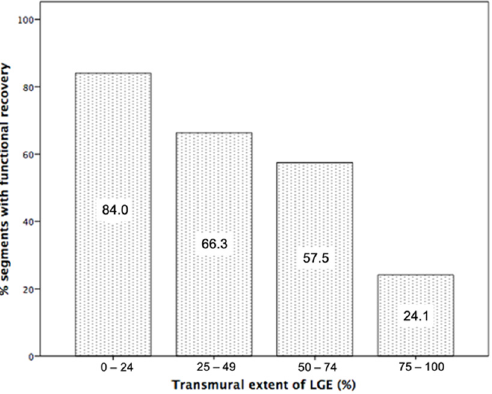
Figure 2. Percentage of segments showing functional recovery according to % of late gadolinium enhancement transmurality (LGE). CMR-FT analysis of radial and circumferential strain was correctly performed in all but 5 segments (feasibility 98.7%) and in all but 4 segments (99.0%) for longitudinal strain (LS). Of the three CMR strain parameters, circumferential strain (CS) showed the strongest predictive value with 73% of accuracy, 68% sensitivity and 81% specificity for a cut-off of − 10.0% (Table 4). Table 4. CMR-FT and LDDSE strain for prediction of functional recovery at follow-up.